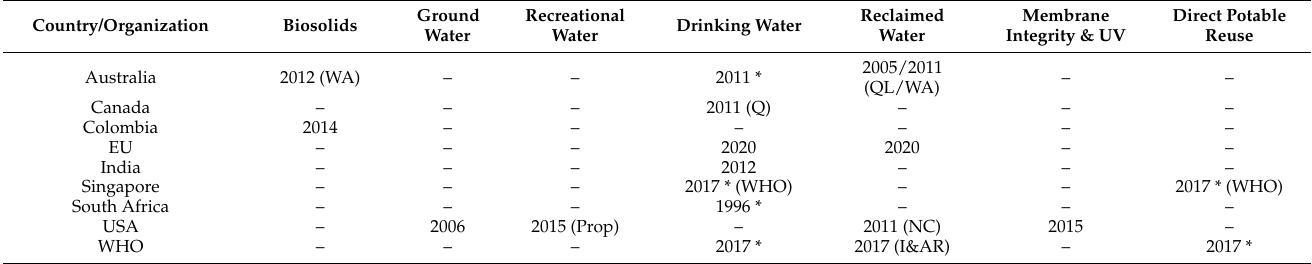
Table 1. Current guidelines and regulations around the globe that include bacteriophages as indicators of fecal pollution [132–144].